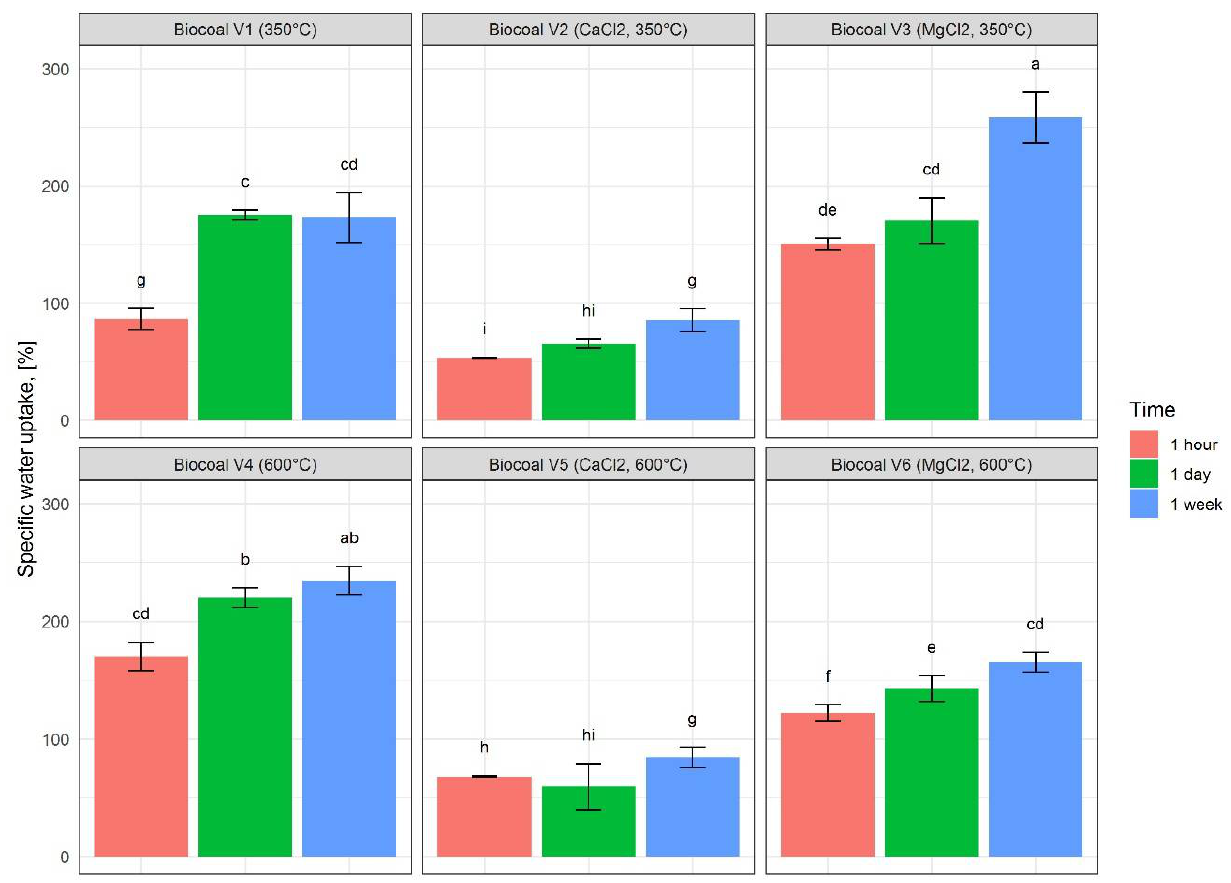
Figure 4. Specific water uptake for the six produced variants of biocoal under different exposure times (one hour, one day and one week). Histograms are charted based on the mean values; error bars indicate the variability between the three replications. Lower case letters indicate significant differences between all the experiments according to Tukey test.